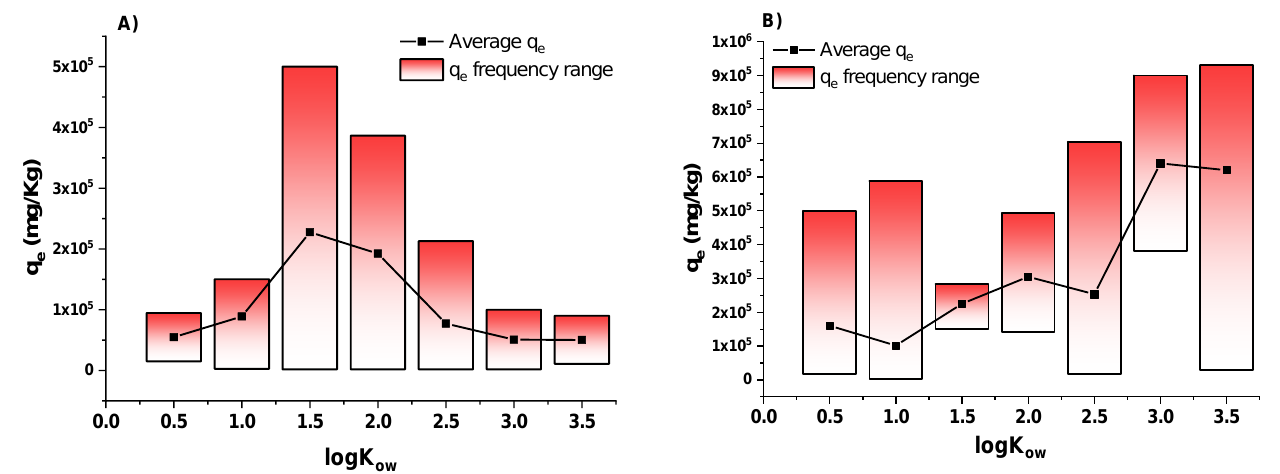
Figure 2. Distribution plot of equilibrium adsorption capacities (q e , mg/kg) as a function of the logK ow of organic target pollutants removed by biochars ( A ) and activated carbons ( B ). n = 50 for both adsorbents. The clusters considered the log K ow range from 0.5 to 3.5.